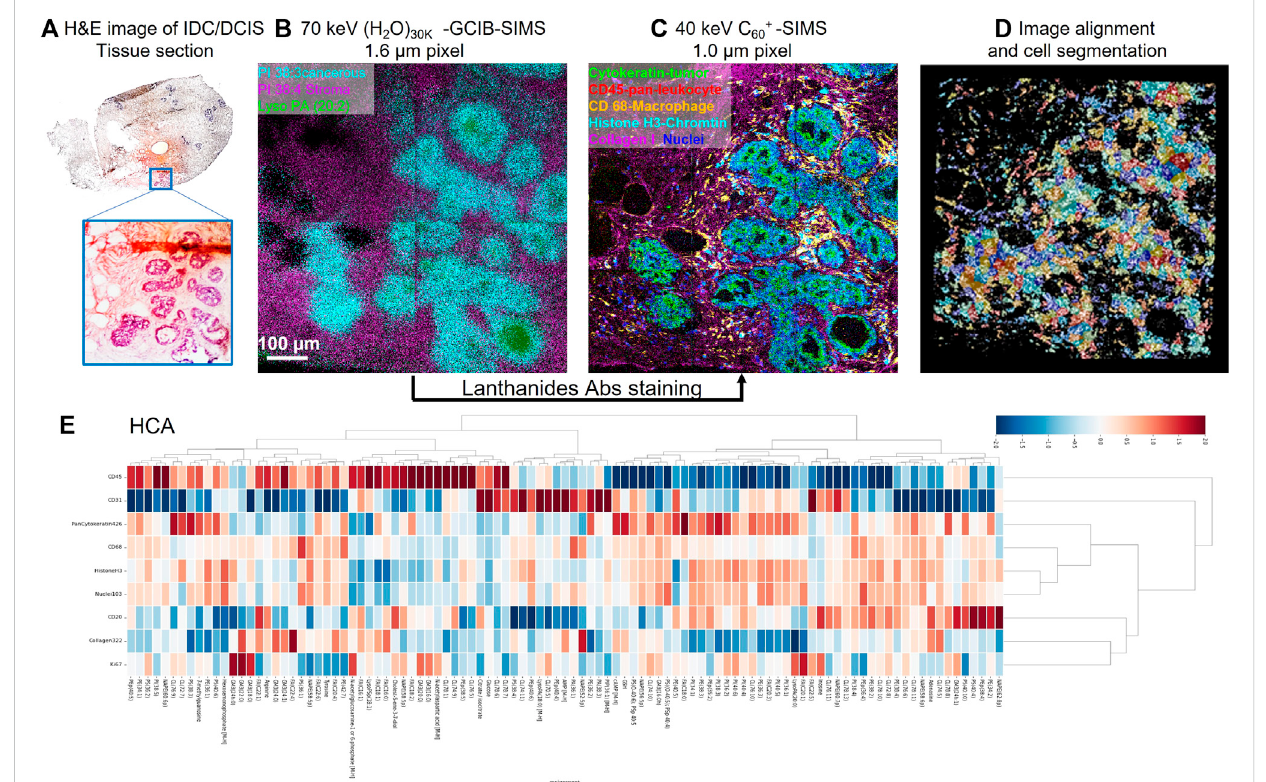
FIGURE 2 Schematicofthework fl owforcell-type-speci fi cpro fi lingofmulti-omicsonIDC/DCIStissuesectionsatthesingle-celllevelwithselectoverlaysand single-ionimagesusing(H 2 O) n -GCIB-SIMSandC 60 -SIMS. (A) H&Estainingimageofasemi-serialsectionofinvasiveductalcarcinoma/ductalcarcinoma in situ (IDC/DCIS) tissue. The enlarged image from the region of interest highlighted in blue shows the tumor region in purple and the stromal region in pink. (B) (H 2 O) n -GCIB-SIMS imaging of a fresh-frozen tissue section. The cryogenic analysis at 100 K was performed on frozen-hydrated tissue sections for molecular imaging (e.g., lipids and metabolites)atabeam spot size of 1.6 µm. (C) C 60 -SIMS imaging ofthe same tissue section stained with a lanthanide-tagged cocktail of antibodies at a beam spot size of 1.0 µm. (D,E) , (D) the image alignment and cell segmentation were used to integrate the omics (E) metabolites, lipids, and proteins into different cell types at single-cell